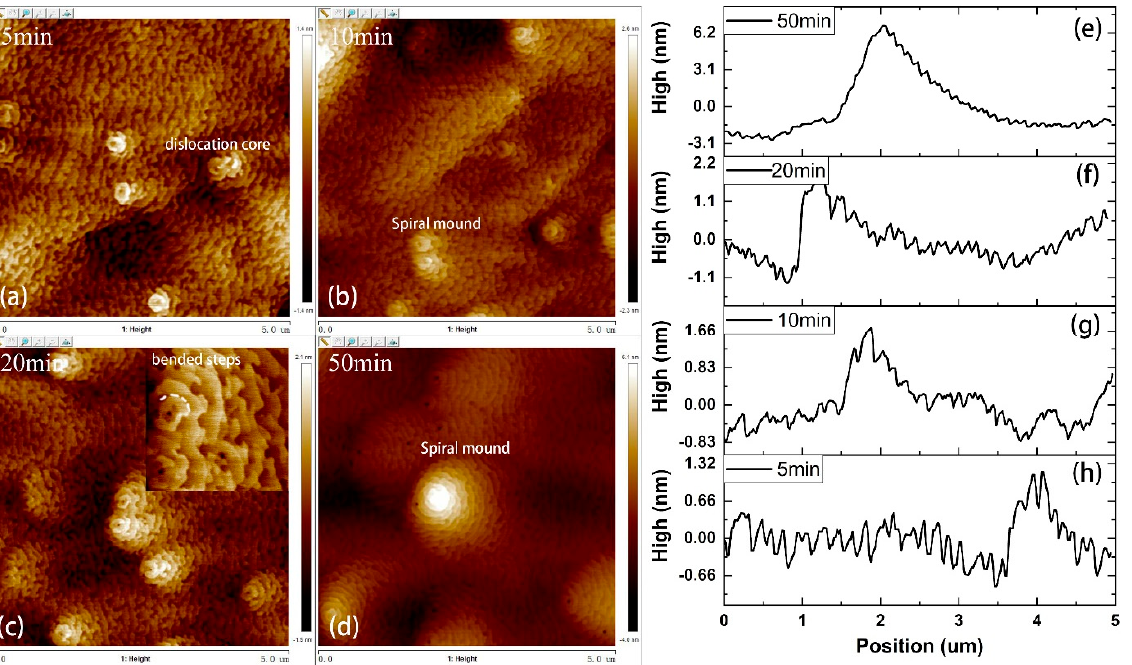
Figure 3. ( a – d ) 5 × 5 µm 2 AFM images of p-InGaN samples with different growth times; ( e – h ) line scans of AFM images (color online).